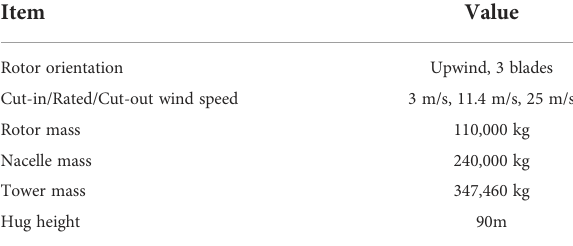
TABLE 1 Summary properties of 5-MW baseline wind turbines.